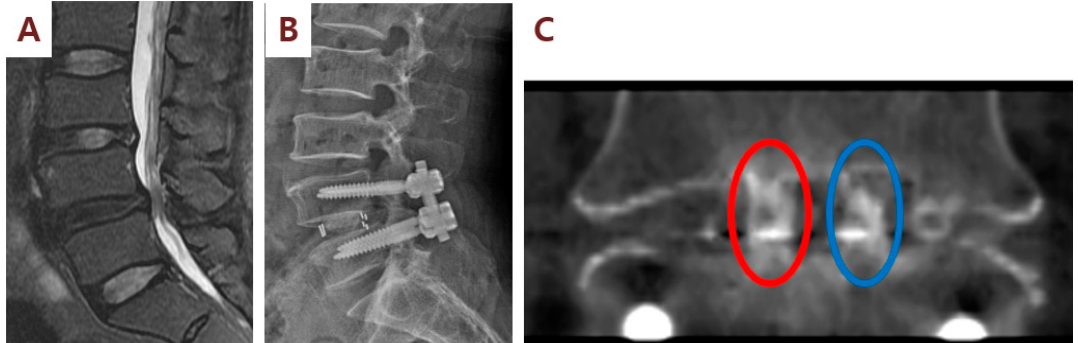
Figure 5. Illustration case (Patient No. 3): A 63-year-old male received posterior lumbar interbody fusion and pedicle screw fixation. ( A ) Preoperative lumbar sagittal MRI demonstrating L4/L5 severe spinal stenosis. ( B ) Postoperative lumbar spine standing lateral view. ( C ) CT coronal view at 6 months after surgery showed the fusion status of cages (red eclipse) filled with SVF and β -TCP mixture on the right side of the patient. By contrast, CT coronal image showed no fusion status (blue eclipse) of cages filled with β -TCP alone on the left side.